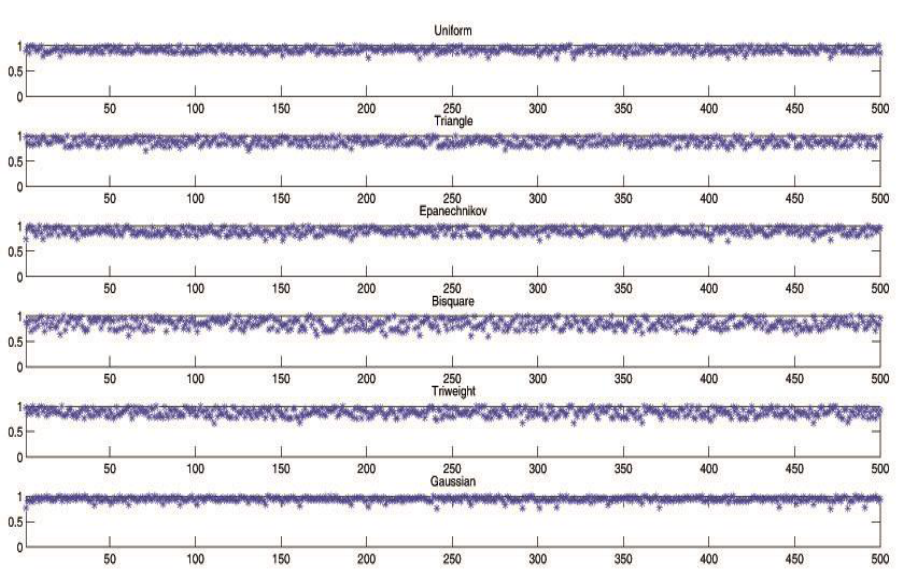
Figure 4. Max ( ) for six kernel functions based on ( ) (